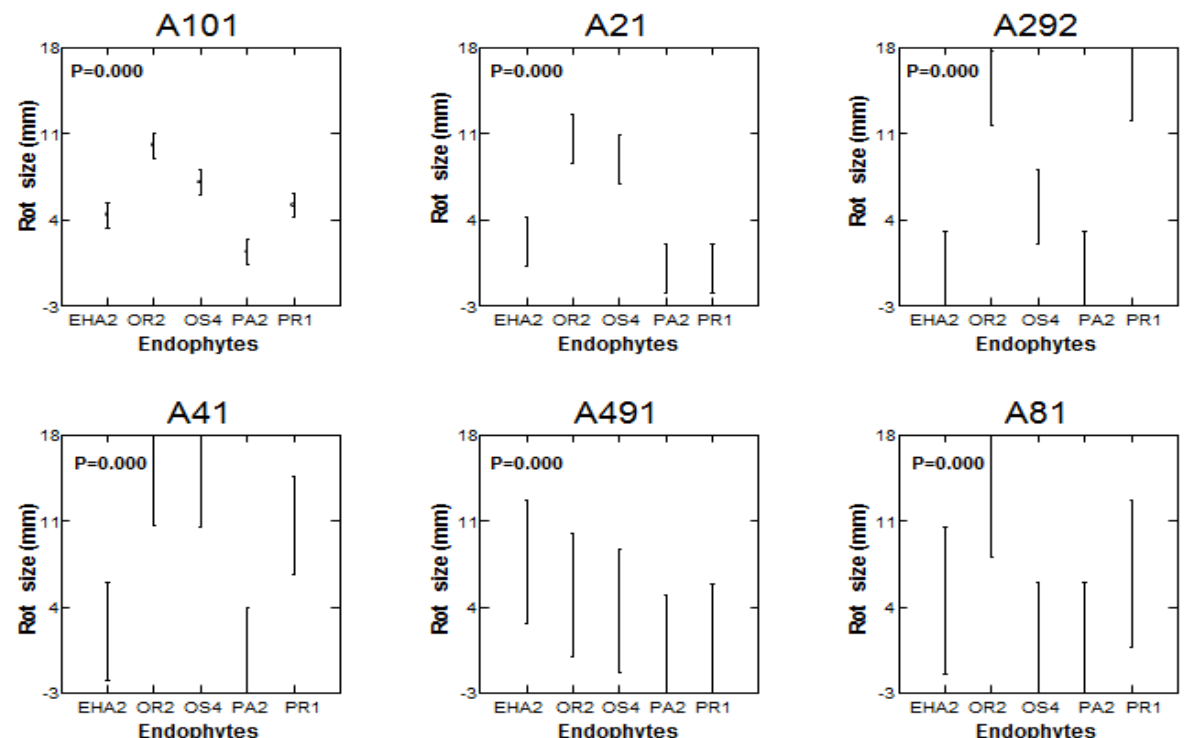
Figure 2. Mean dimensions of rots caused by Pectobacterium spp. inoculated in vitro on disks of potato tubers of the vari- ety Spunta, treated with different strains of endophytic bacteria. EHA2= Bacillus spp.; OR2= B. methylotrophicus ; OS4= B. methylotrophicus ; PA2= Bacillus spp.; PR1= Bacillus spp. A101, A21, A292, A41, A491 and A81 are Pectobacterium spp. strains identified by biochemical, physiological and pathogenicity tests following the procedure described by Schaad et al. ,